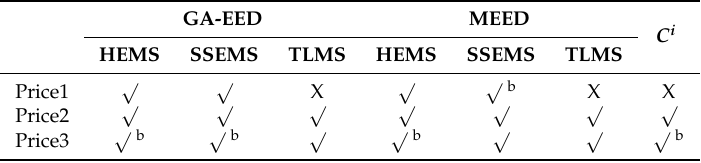
Table 9. Performance summary for various dynamic pricing options using GA-EED and